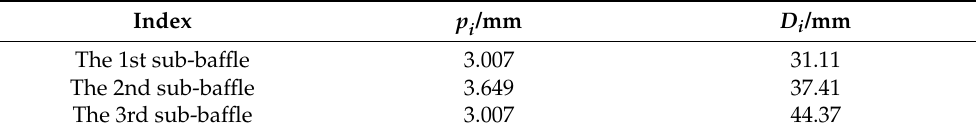
Table 2. The relevant design parameters of sub-baffles.